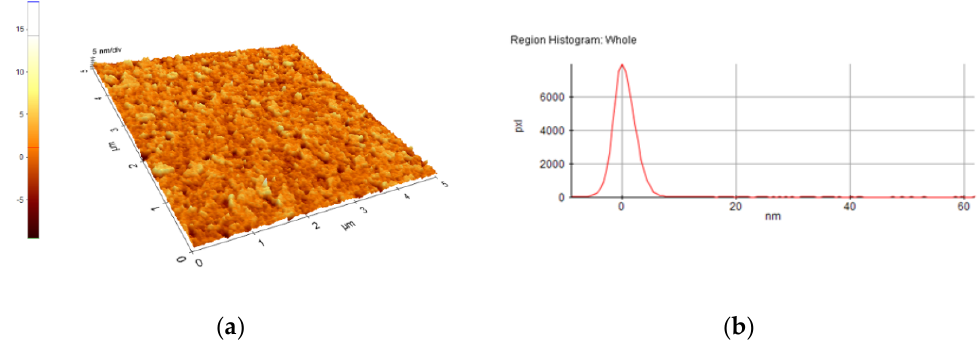
Figure 8. AFM image of 4%GO-SiO 2 -P 2 O 5 /glass film: ( a ) morphology, ( b ) region histogram.